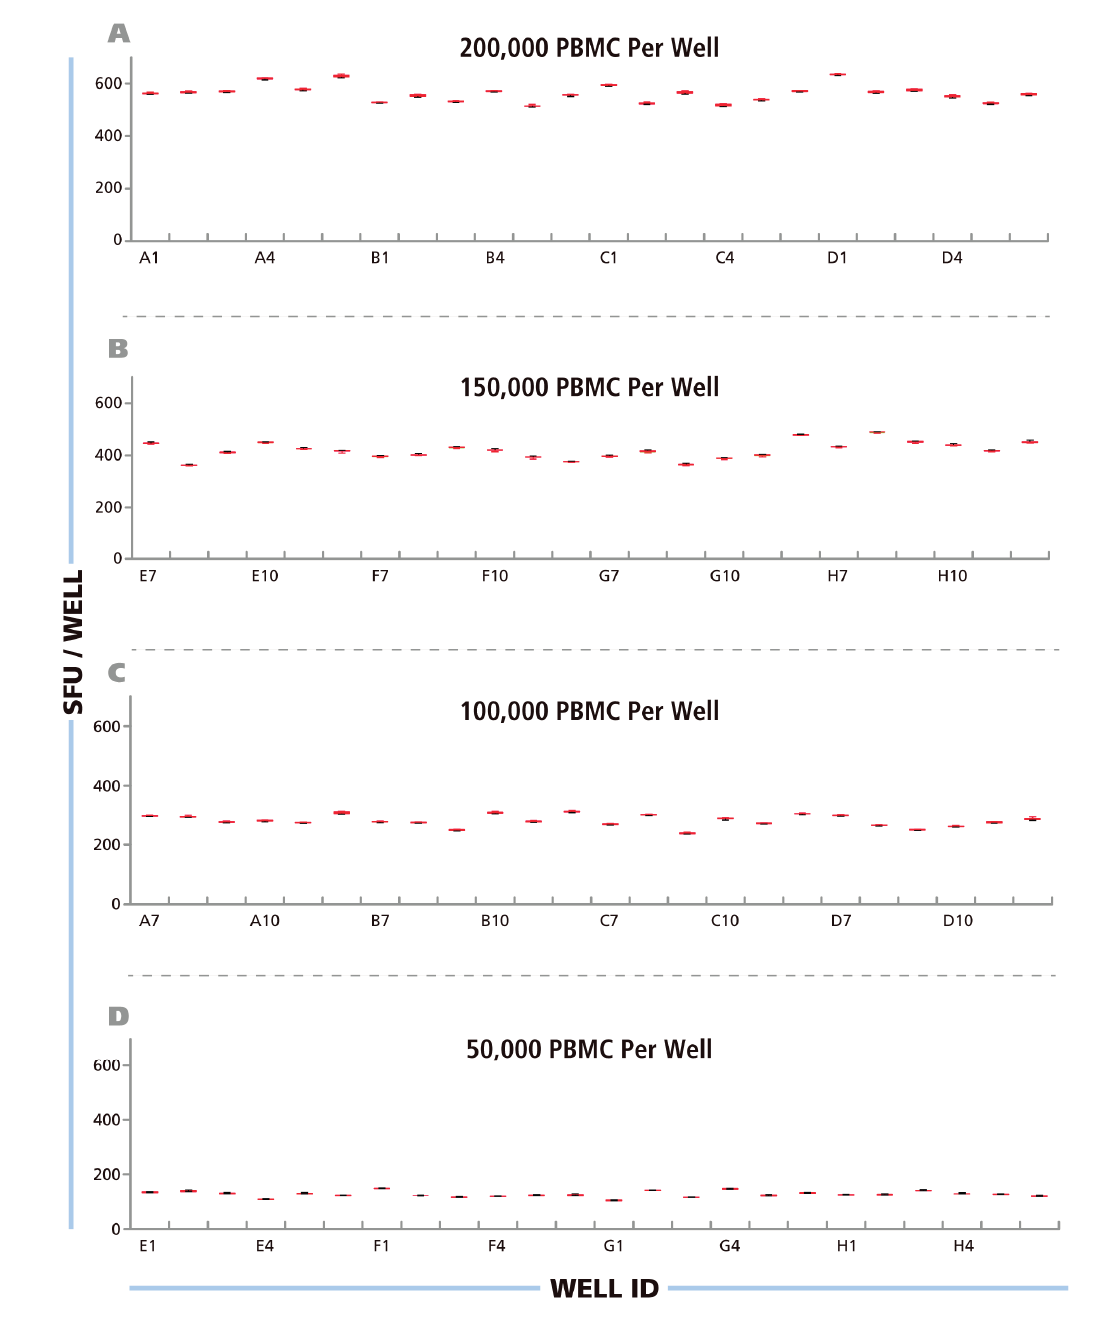
Figure 3. Repetitive scans show minimal intra-well variability of ELISPOT counts – inter- well variability for replicates follows Normal distribution. The Reference Plate was scanned 80 times consecutively over a period of 7 hours. The resulting image files were counted with fixed Reference Counting Parameters. For each well, for the four Reference Plate quadrants ( A ) at 200000 PBMC /well, ( B ) 150000 PBMC/well, ( C ) 100000 PBMC/well and ( D ) 50000 PBMC/well, the mean of the 80 scans is shown with SD. Note, that error bars are <1% and therefore barely visible in the